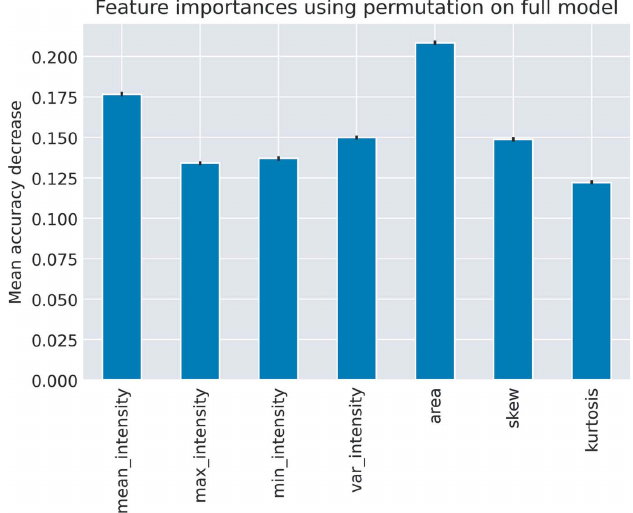
Figure 10 Feature importance for square classification. Results obtained for feature importance of square image summary statistics to predict whether a square is selected using an RF model. Area and mean pixel intensity are the most important features.